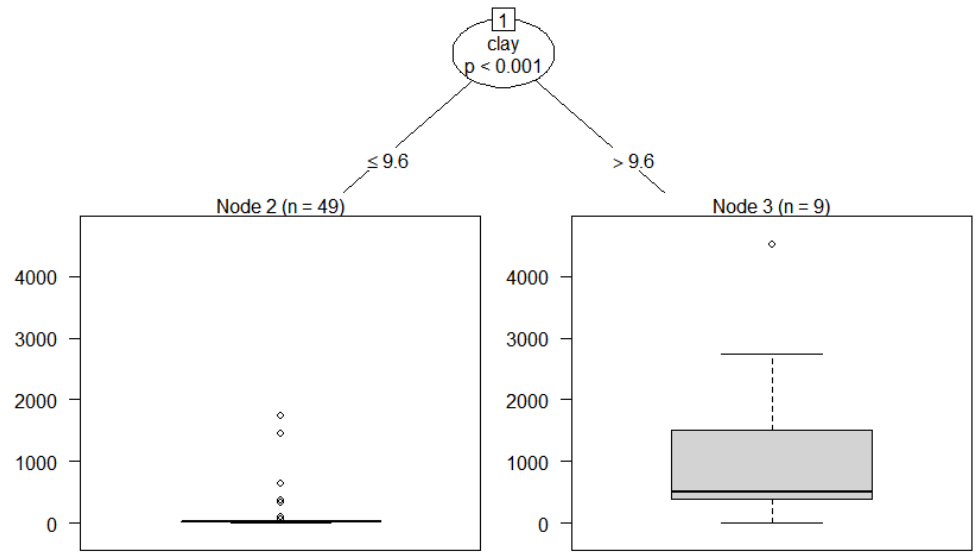
Figure 5. CIT analyses for Sb in soils ( n : the number of samples; unit: mg/kg).